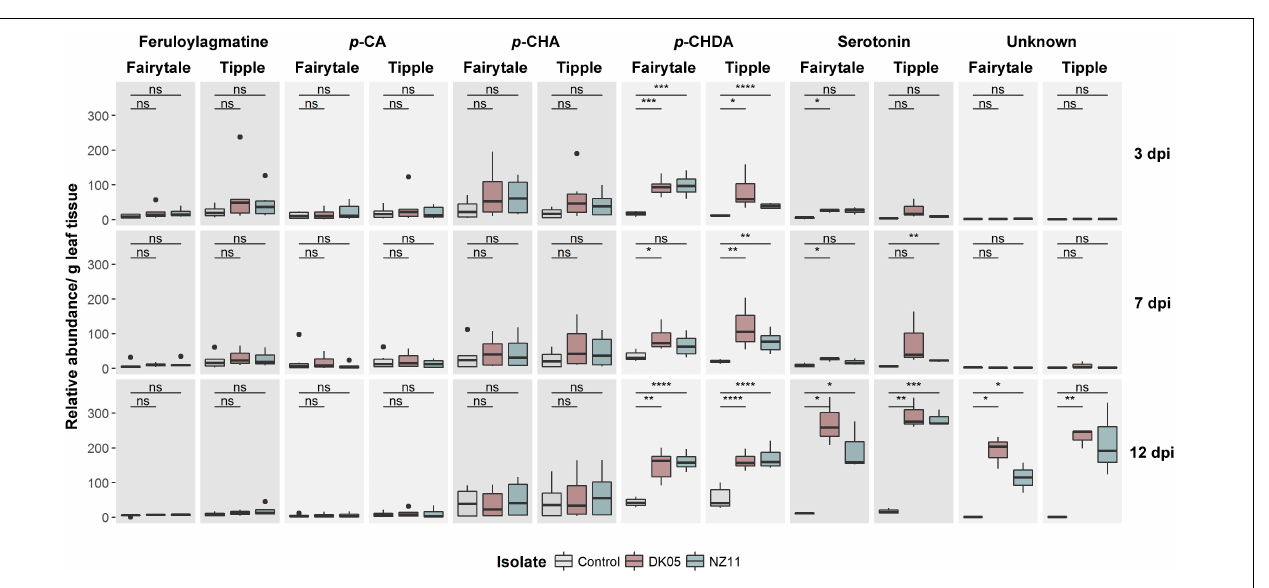
FIGURE 7 | Accumulation of Ramularia collo-cygni ( Rcc ) responsive secondary metabolites during Rcc colonization in different barley cultivars ( Hordeum vulgare L ). Two different barley cultivars (cv Fairytale and cv Tipple) were monitored for disease development over a specific time course. Metabolite depicted here are responsive too Rcc . Two different fungal isolates [DK05 (red) and NZ11 (blue)] were used for separate infections. Control (gray) treatments were mock inoculates with water. Data shown as box plots separated by metabolites in different varieties; unpaired t -test; * p < 5e-2, ** p < 1e-2, *** p < 5e-3, and **** p < 1e-3, ns, not